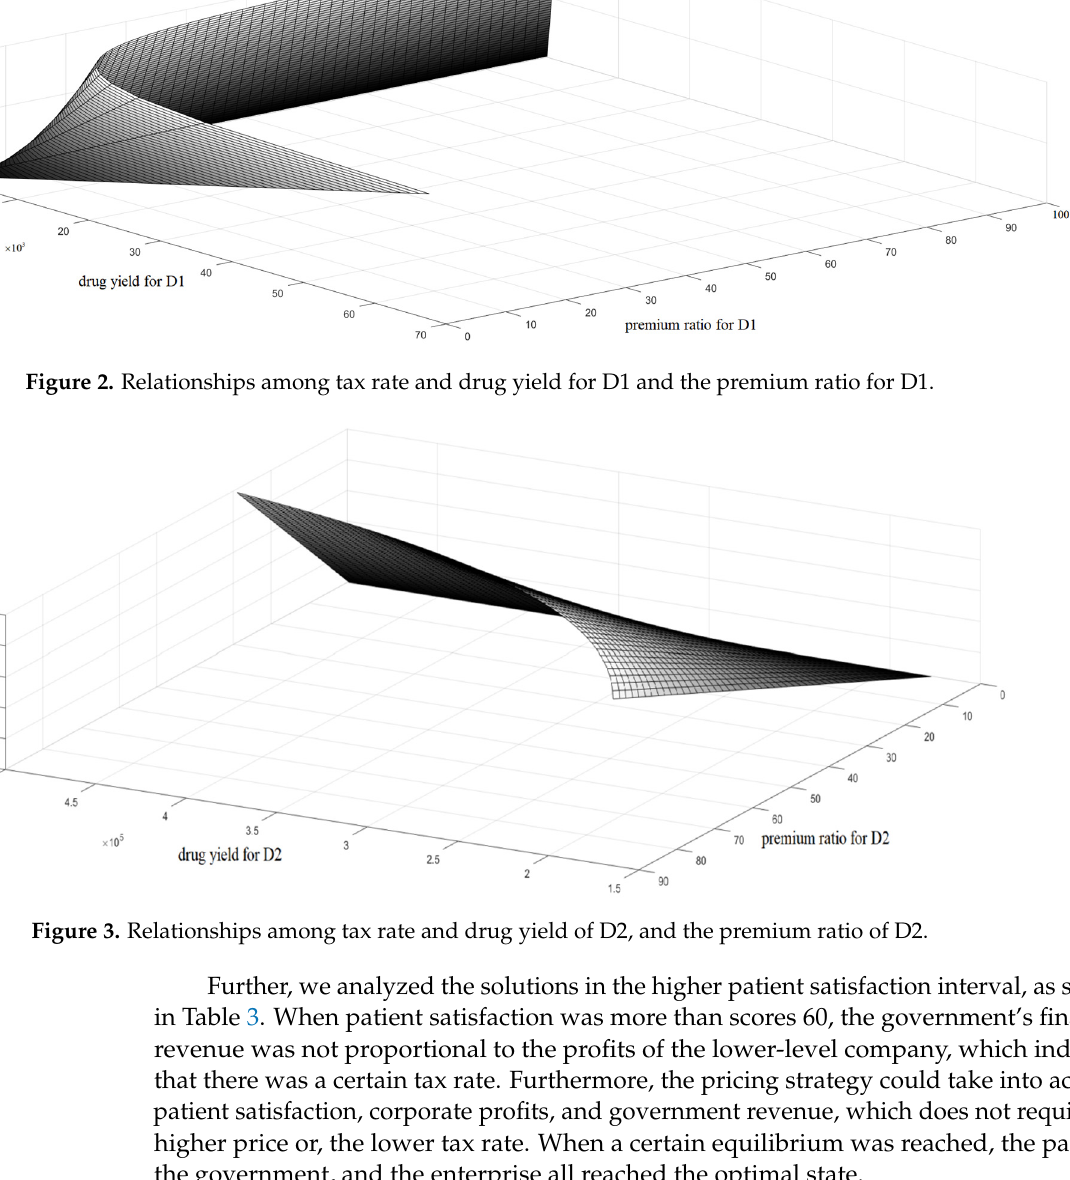
Table 3. The relationship between enterprise profit and financial revenue under high